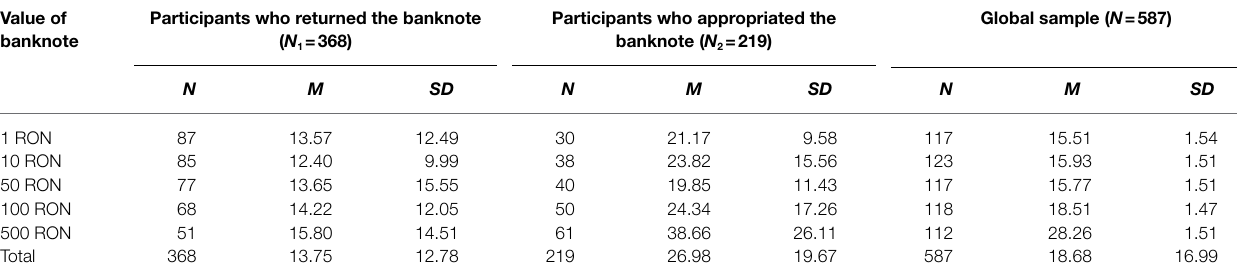
TABLE 3 | Means and SD of the number of words in the post-experimental